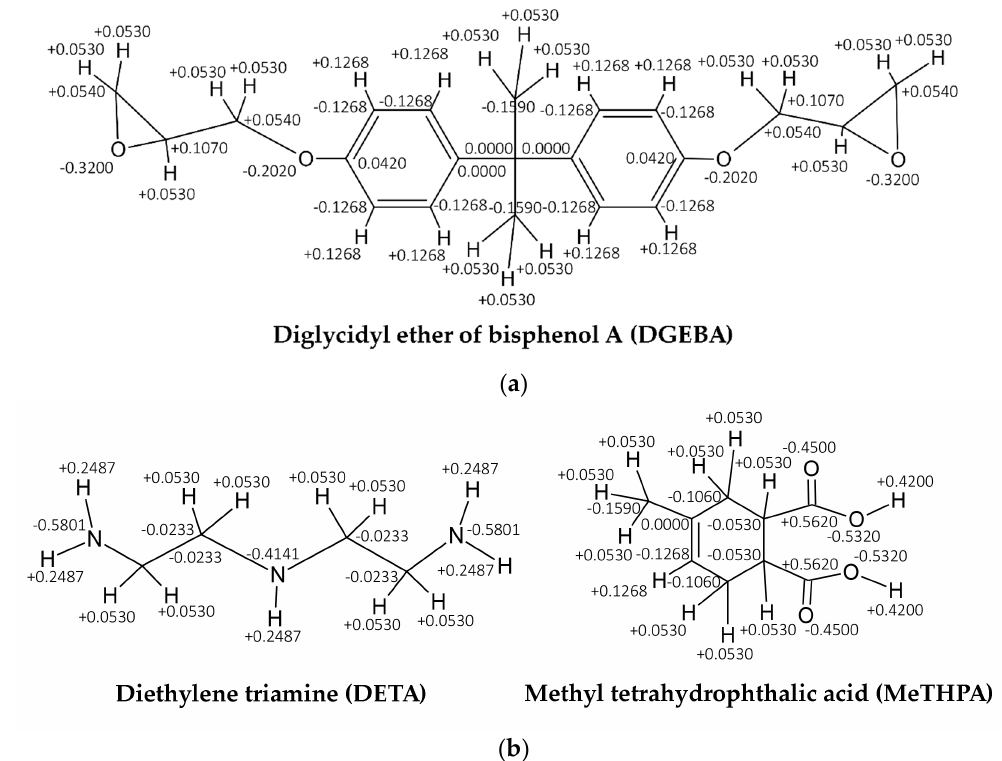
Figure 1. Structure and partial atomic charges of epoxy resin monomers: ( a ) epoxy molecule (DGEBA); ( b ) hardeners (DETA and MeTHPA).